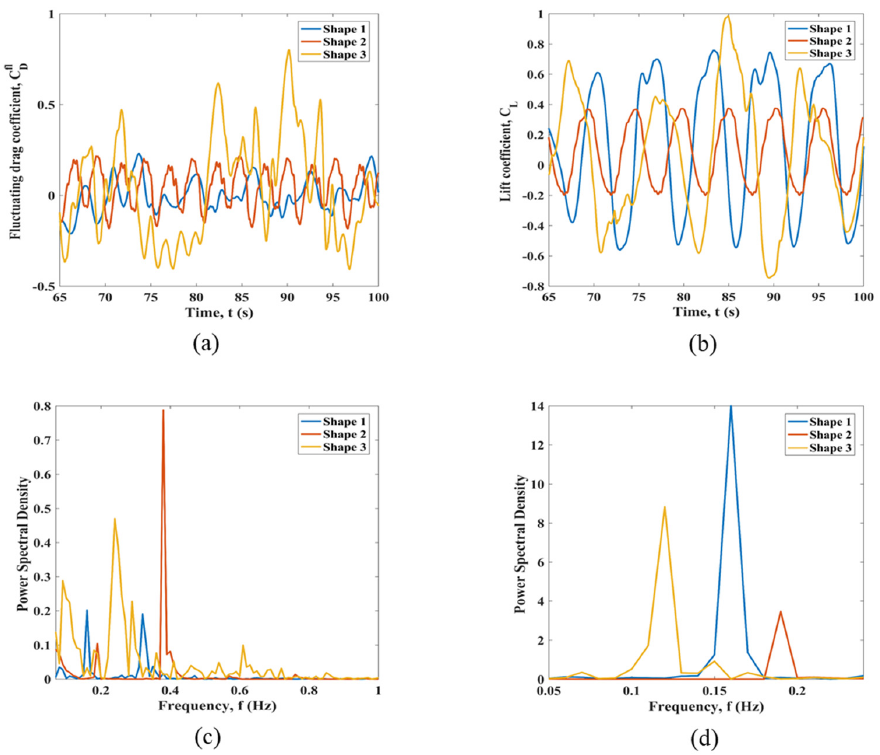
Figure 5. Fluid force coefficients for cylinder 1 immersed in planar sheared flow: ( a ) time history of the fluctuating drag coefficient; ( b ) time history of the lift coefficient; ( c ) the fluctuating drag coefficient FFT; ( d ) the lift coefficient FFT.